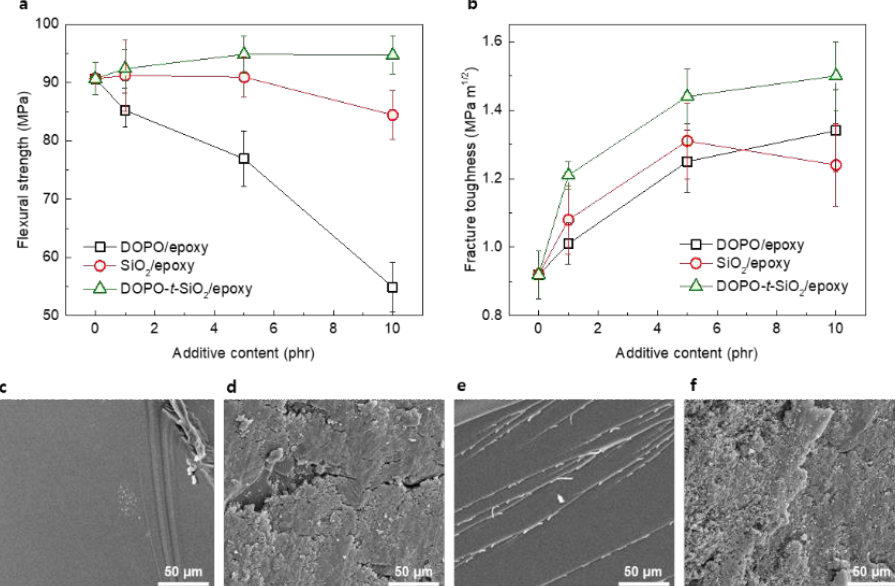
Figure 3. ( a ) Flexural strength and ( b ) fracture toughness of DOPO/epoxy, SiO 2 /epoxy and DOPO- t -SiO 2 /epoxy nanocomposites with the content of additives, respectively. SEM images of ( c ) pristine epoxy, ( d ) DOPO/epoxy, ( e ) SiO 2 /epoxy and ( f ) DOPO- t -SiO 2 /epoxy nanocomposites, respectively.